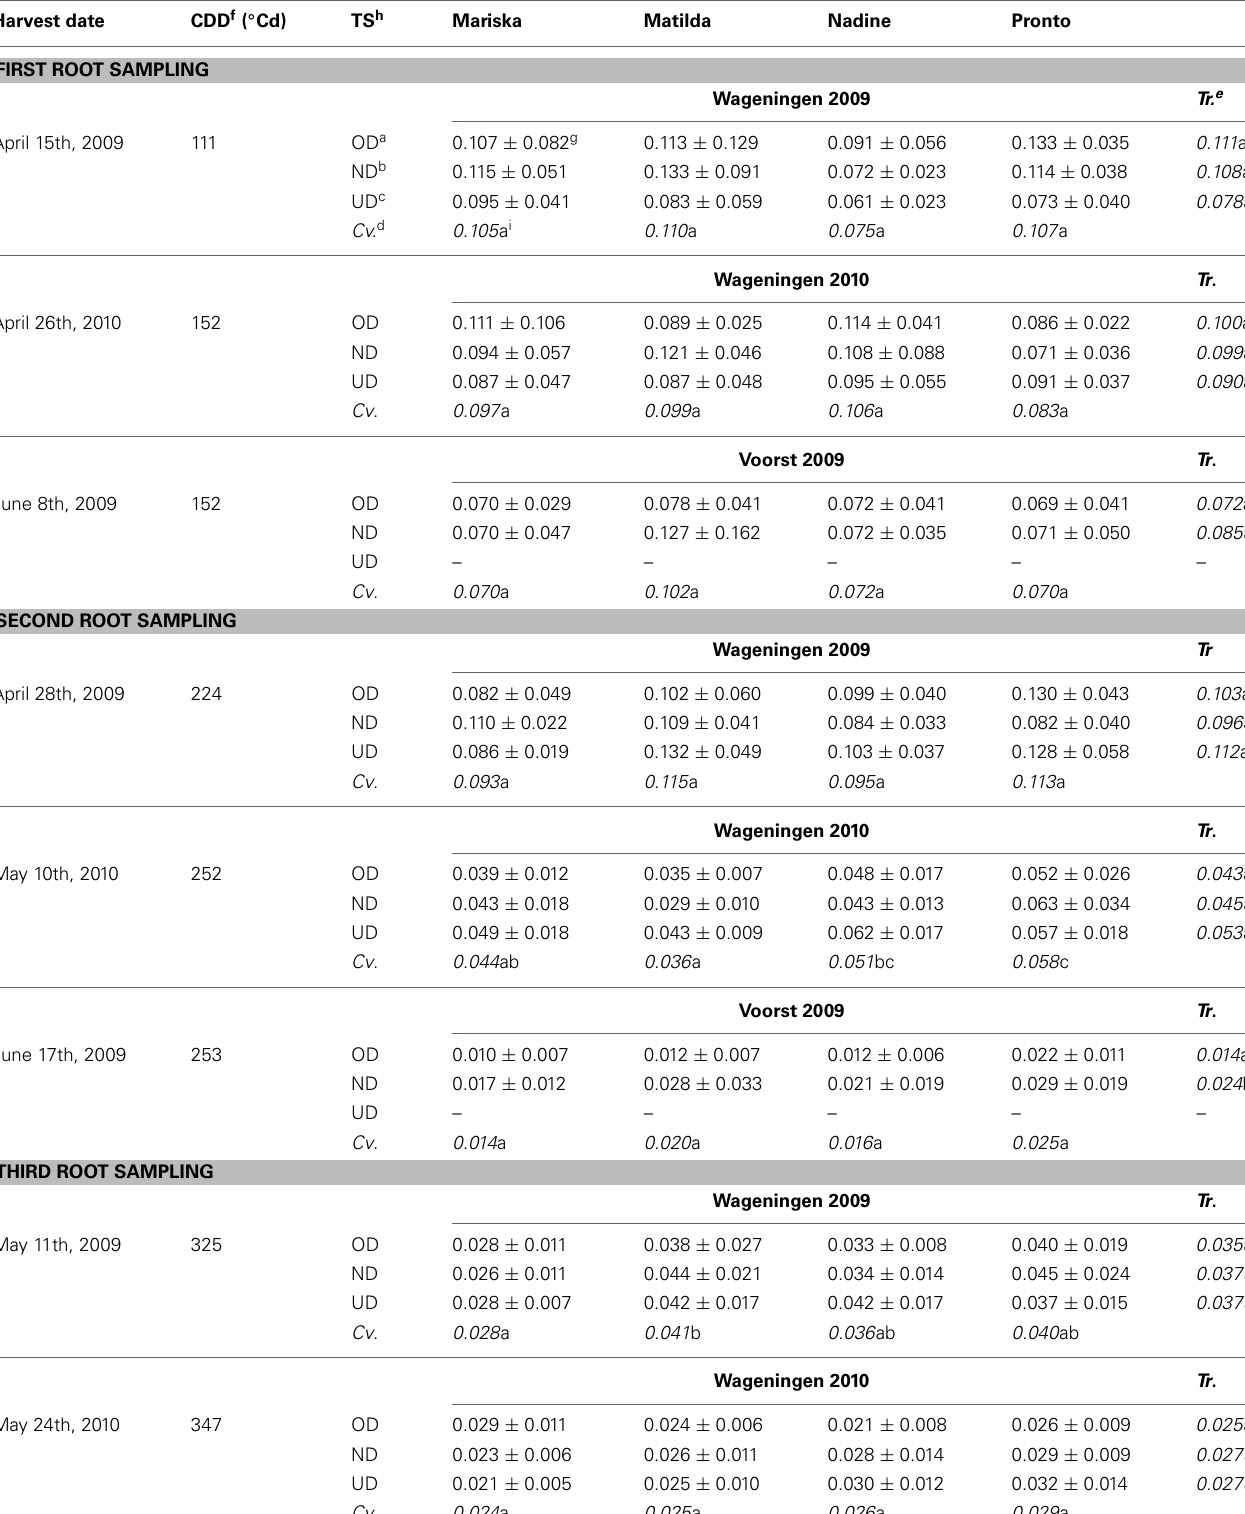
Table 6 | Average root:shoot ratios of the four cultivars at first, second and third root sampling, after establishment from three different transplant sizes in each of three